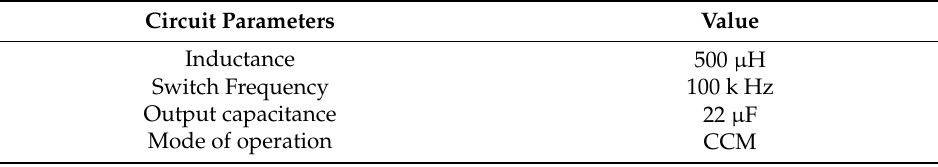
Table 2. Parameters of PV module.